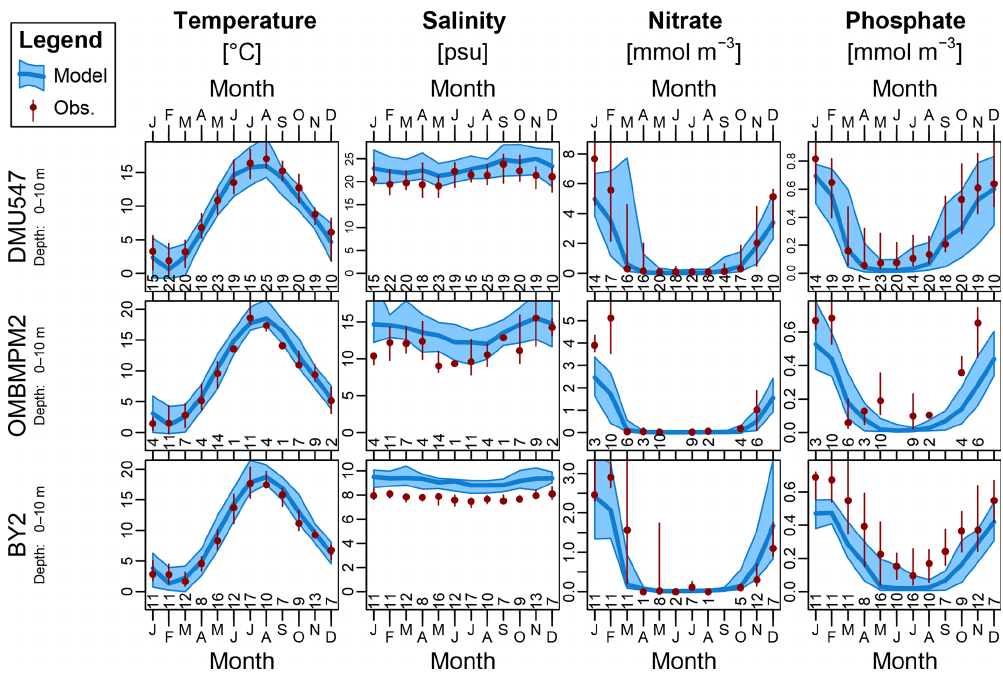
Figure 5. Monthly climatological medians of observational (dots) and modeling data (solid lines) at the sea surface (top 10m) from 2006 to 2012. Each row presents the data of one station ordered from west (top) to east (bottom). The station names and depth range are given on the left. Each column presents one state variable: salinity, temperature, nitrate, and phosphate (from left to right). Vertical lines through the dots and the shaded area around the solid line show the monthly variability represented by the 10th and 90th percentiles. The number of observational data points per month is given above the x axis of each plot. A similar figure showing data at the other three stations is provided in the